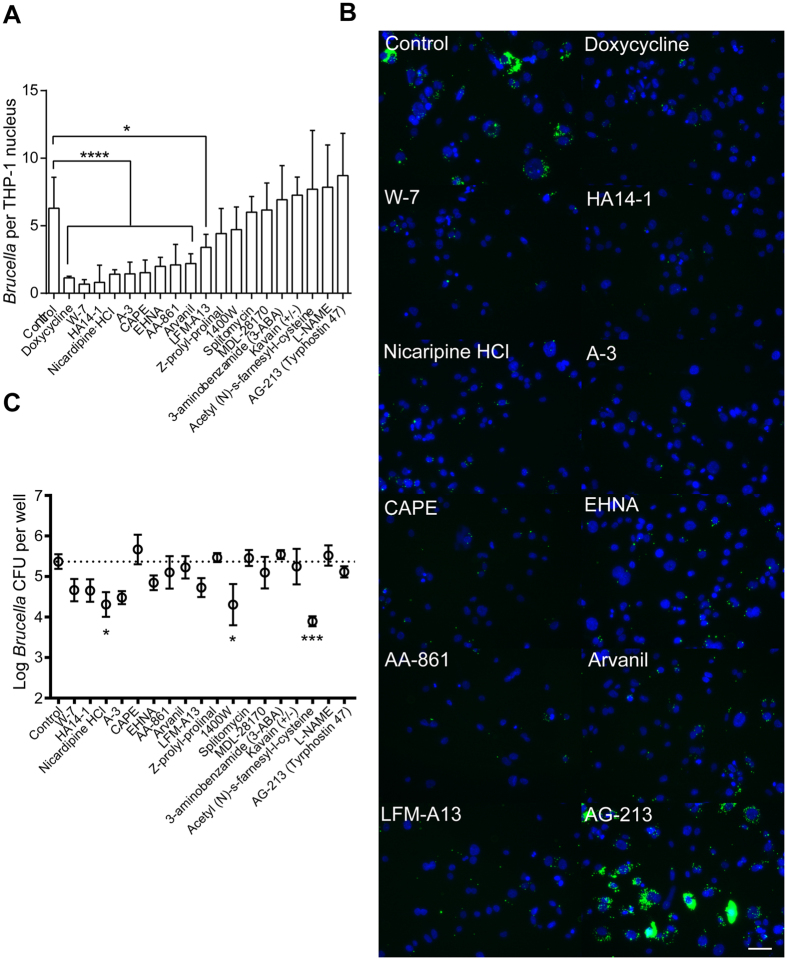
Efficacy of non-cytotoxic host-specific compounds as inhibitors of B. abortus intracellular replication in a THP-1 infection model. (A) Quantification of inhibitory efficacy of compounds, measuring the average ratio of bacteria-to-nucleus in THP-1 cells treated with each of the 18 non-cytotoxic host-specific compounds in a single experiment. Statistical significance was evaluated from ≈7 images per treatment using one-way ANOVA followed by Dunnett’s test (*p < 0.05, ****p < 0.0001). Error bars represent +/− standard deviation. (B) Sample fluorescence images of nuclei (blue) and intracellular B. abortus (pseudocolor green) assessing efficacy of each of the 9 final host-specific compounds that significantly inhibited infection by B. abortus. Doxycycline is a positive control and AG-213 represents a non-hit compound that did not have any effect on infection. Scale bar = 50 μm. (C) B. abortus CFU counts generated from infected THP-1 treated with 18 identified non-toxic compounds that presumably target host cells to inhibit B. abortus infection. Data represent an average from 3–7 biological replicates. Error bars represent +/− SEM.